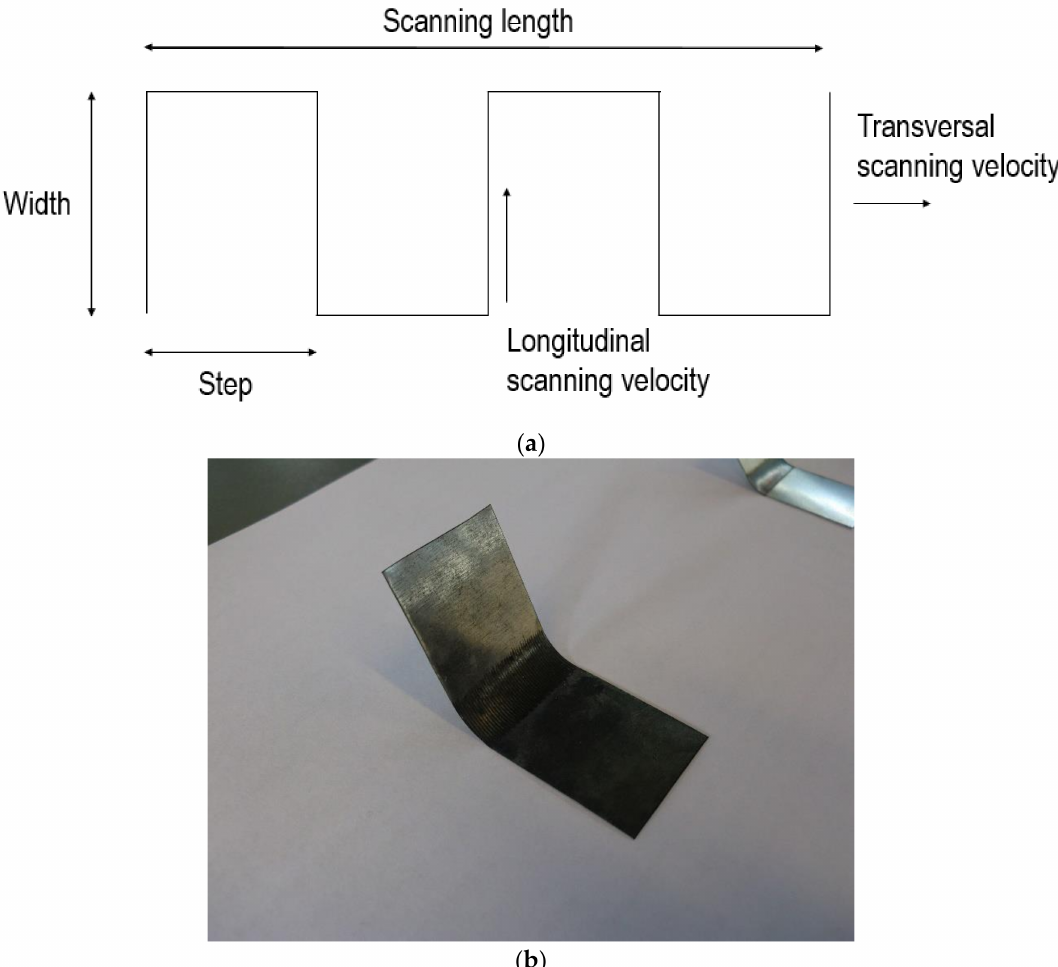
Figure 1. Single S-shape scanning path: ( a ) laser scanning path and ( b ) final bent sample of one of the studied